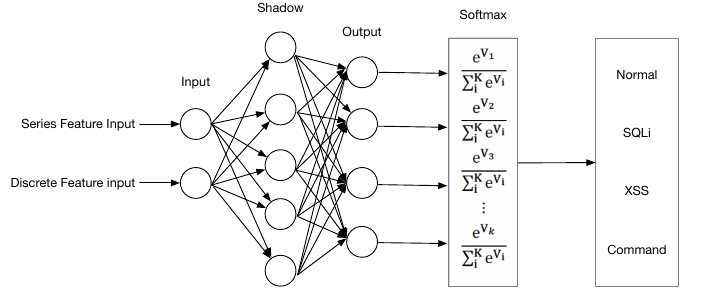
Figure 2. The architecture of